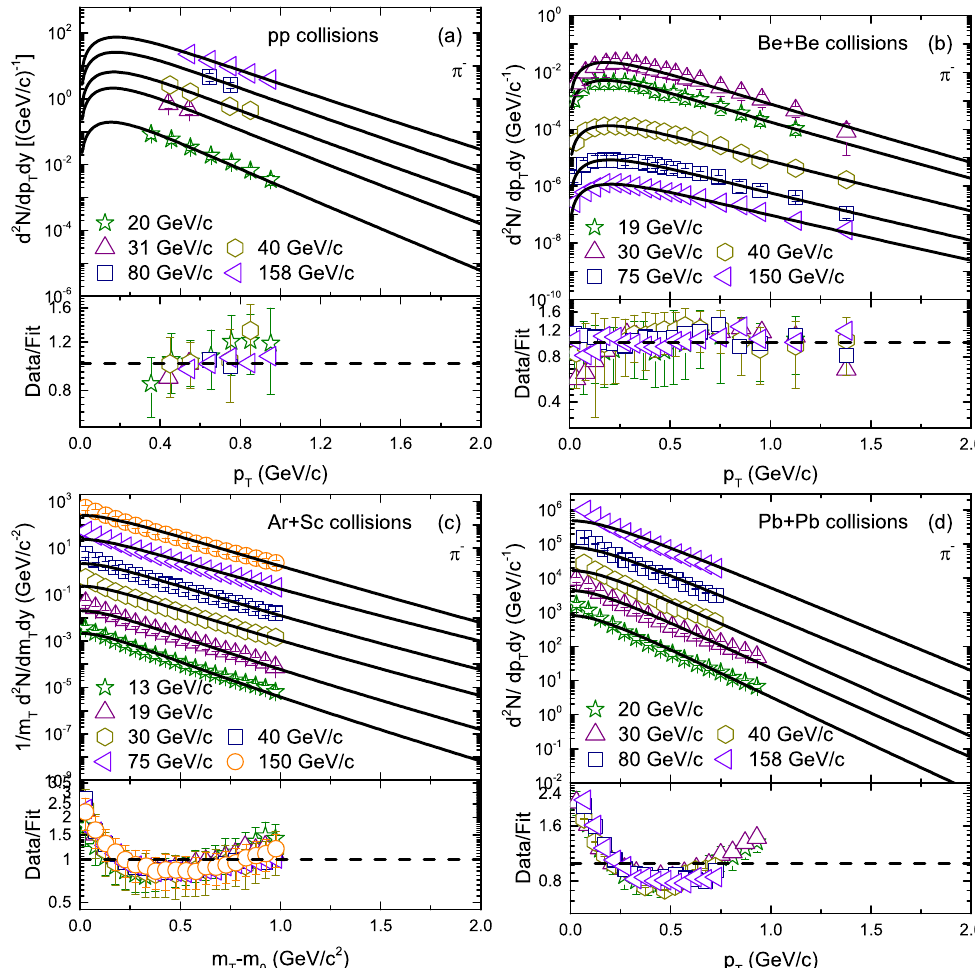
Figure 1. Transverse momentum spectra of π − produced in pp, and the most central Be − Be, Ar − Sc, and Pb − Pb collisions at different energies at | y | = 0.1 rapidity interval. The symbols are the experimental data of the NA61/SHINE [54–56] and NA49 experiments [54–56,58] measured by SPS CERN. The curves represent our fit by Equation (1). The corresponding data/fit ratios are followed in each